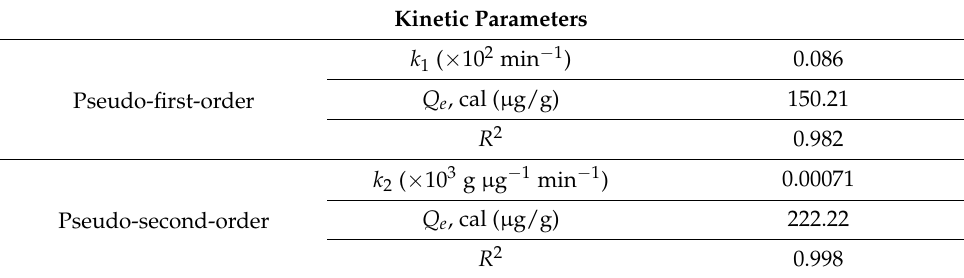
Table 3. Pseudo-first- and second-order kinetic constants of E2-NP/BC-NFs. Kinetic